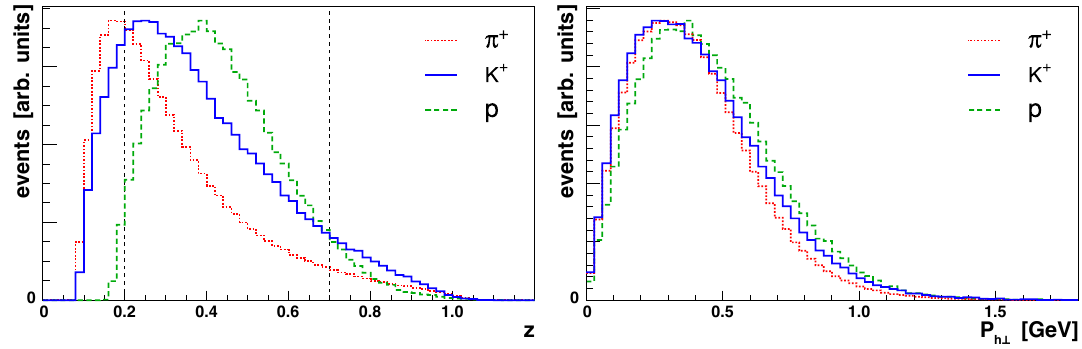
Figure 5 . Shape comparison of arbitrarily normalized π + (red dotted line), K + (blue line), and proton (green dashed line) yield distributions in the hadron variables z (left) and P h ⊥ (right). The region between the two vertical dashed lines indicates the range in z used for the semi-inclusive DIS sample, while events in the extended range 0 . 7 < z < 1 . 2 are analyzed only in the one-dimensional z binning.